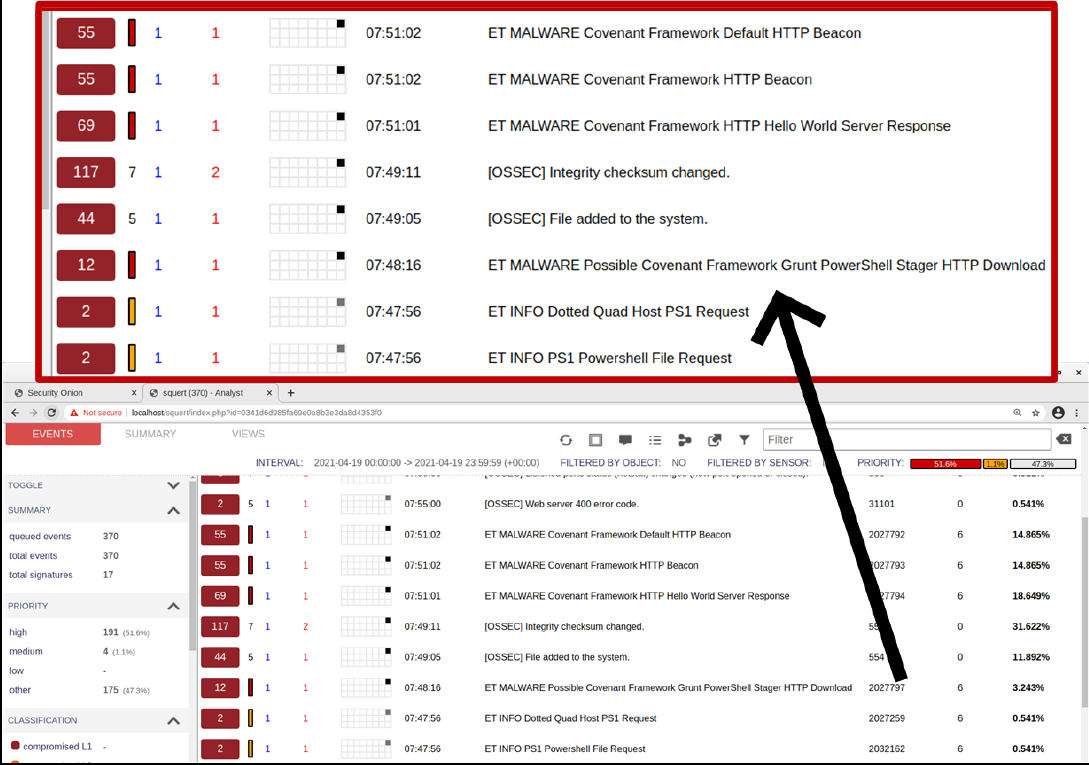
Figure 7. Squert web interface alerts.